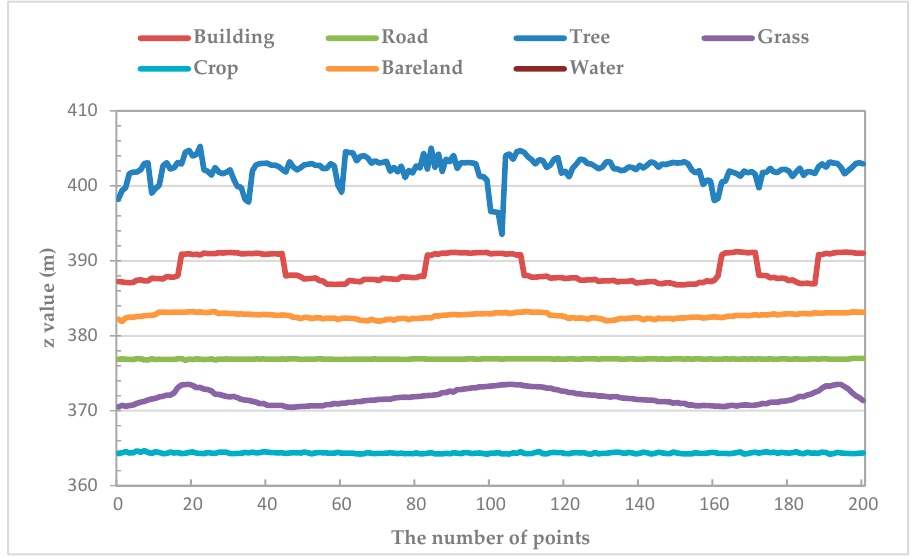
Figure 3. Profile of surface elevation fluctuation for seven classes.